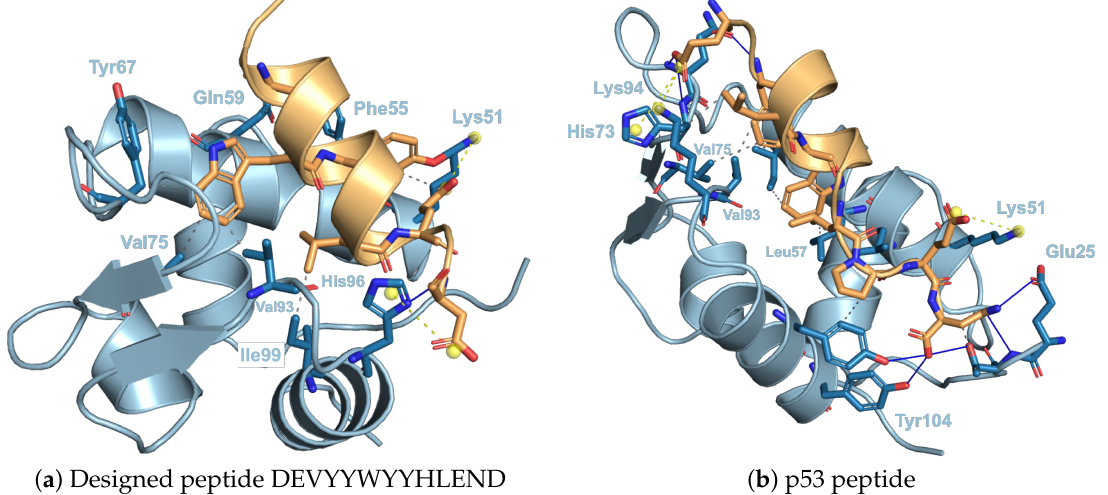
Figure 7. Interatomic interaction analysis for MDM2 with the designed peptide DEVYYWYYHLEND and p53 peptide using PLIP. Interatomic interaction between MDM2 and the designed peptide ( a ); interatomic interaction between MDM2 and the p53 peptide ( b ). Light blue color indicates MDM2. Light orange indicates the designed peptide ( a ) and p53 peptide ( b ). Hydrophobic bonds, hydrogen bonds, salt bridges, and charge centers are indicated by gray dashed lines, blue solid lines, yellow dashed lines, and the yellow sphere,